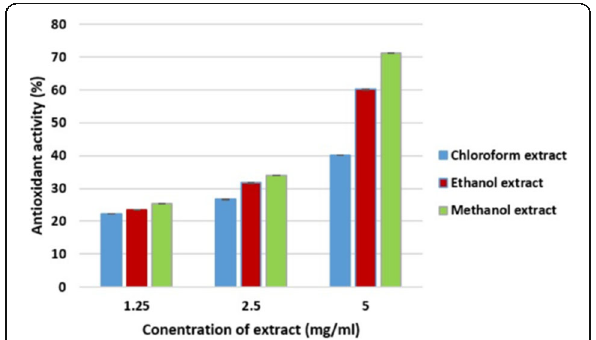
Fig. 5 Antioxidant activity of O. ferruginea stem bark in different